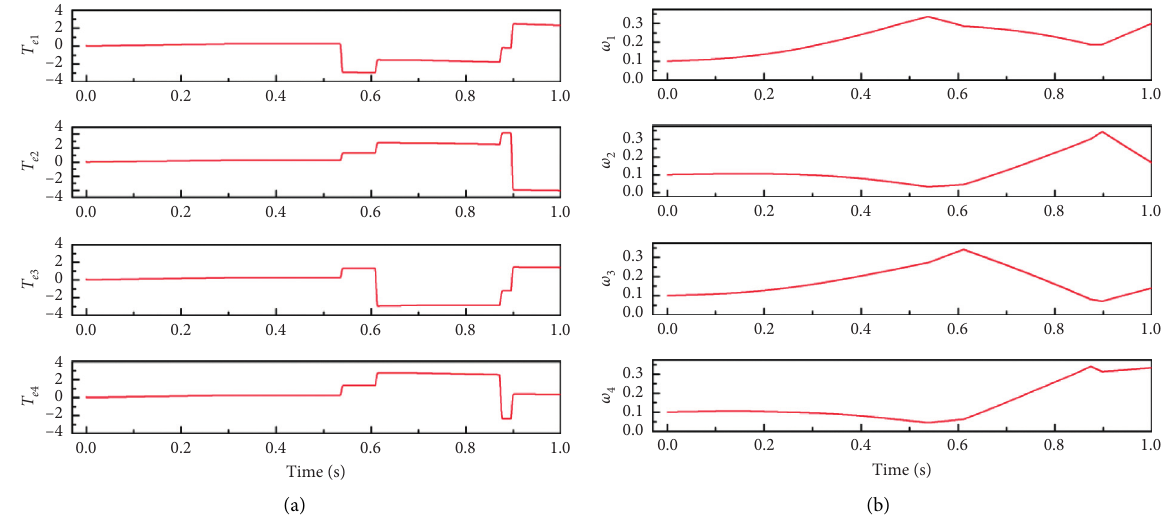
Figure 7: Output curve of the TACTC with AW: (a) the output torque curve, (b) the output angular velocity